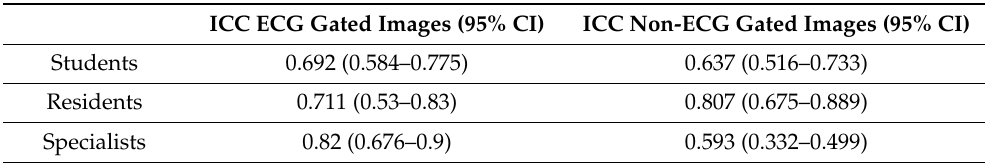
Table 4. Intra-rater reliability ICC for the three groups of reporters, detailed by the usage of gating for image acquisition (two-way mixed, absolute agreement, single